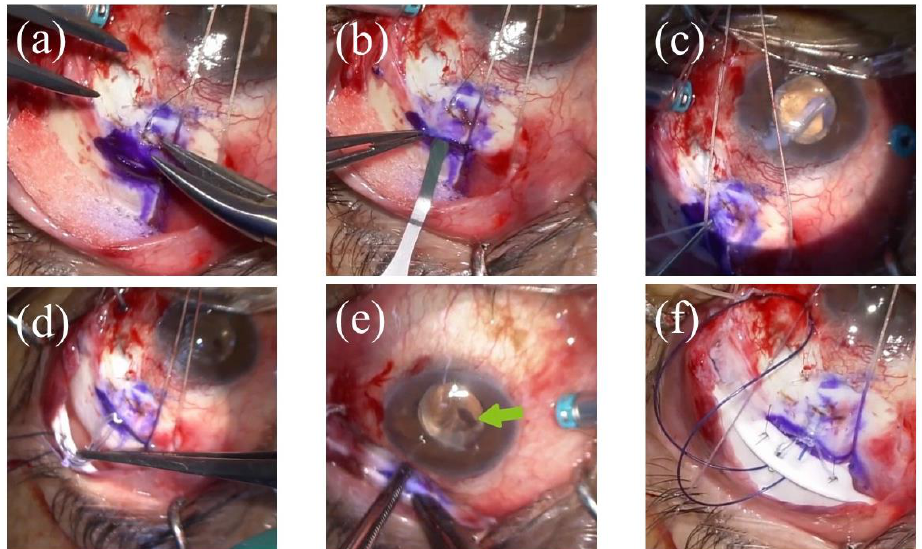
Figure 3. Surgical Procedure; ( a ) a needle penetrated the sclera 4 mm posterior to the corneal limbus; ( b ) a 4 mm long scleral tunnel was created with a 1.5 mm slit knife between the marks; ( c ) both tips of the silk thread were grabbed with fine forceps and inserted into the scleral tunnel; ( d ) the U-shaped tube was introduced into the scleral tunnel by pulling the guidance silk thread; ( e ) the tip of looped tube was confirmed through the pupil (green arrow); ( f ) the stent suture was fixed near the corneal